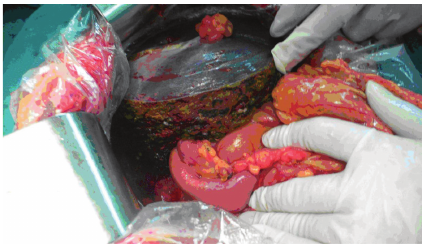
Figure 5: Right hepatectomy, bile duct resection, and left hepatico- jejunostomy.